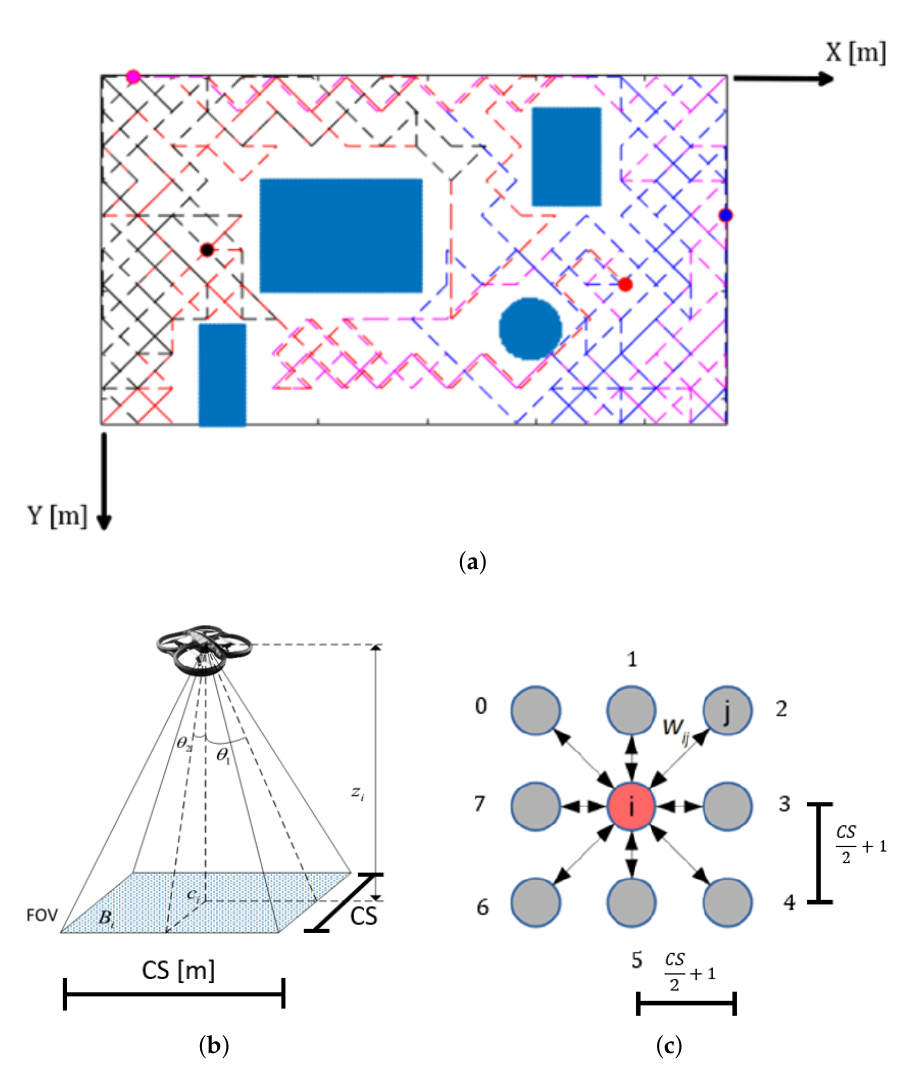
Figure 3. In ( a ) an example of the cooperative coverage planning performed in this work. In ( b ), the square Field of View (FOV) of the UAV assumed in this work. In ( c ), a small bio-inspired neuronal network grid as defined in our